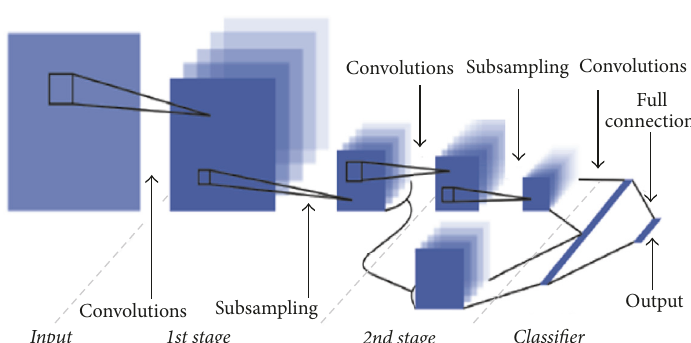
Figure 6: Architecture of convolutional neural network [10].